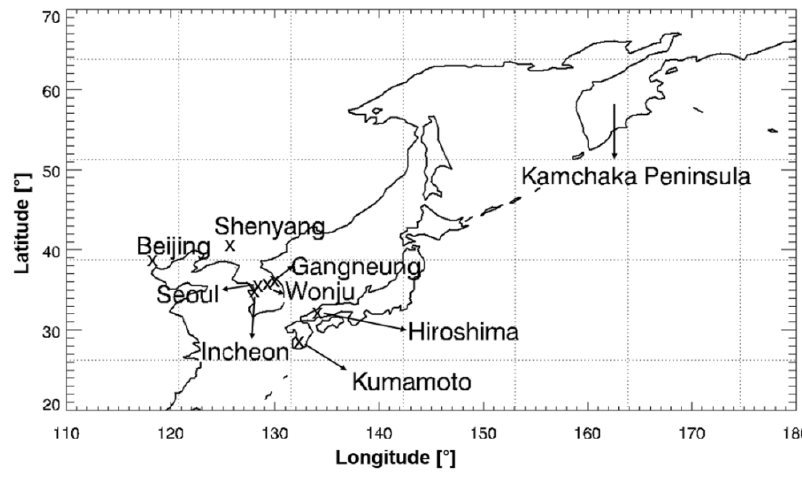
Figure 1. Locations of SO 2 source and receptor sites.